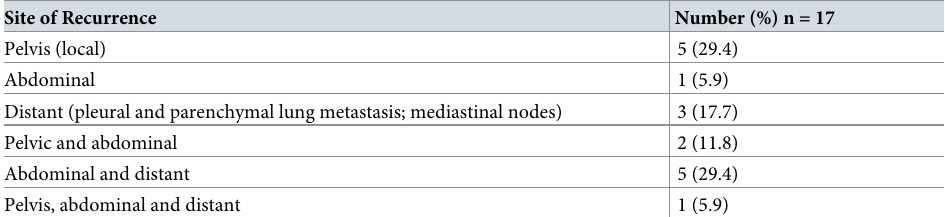
Table 5. Sites of